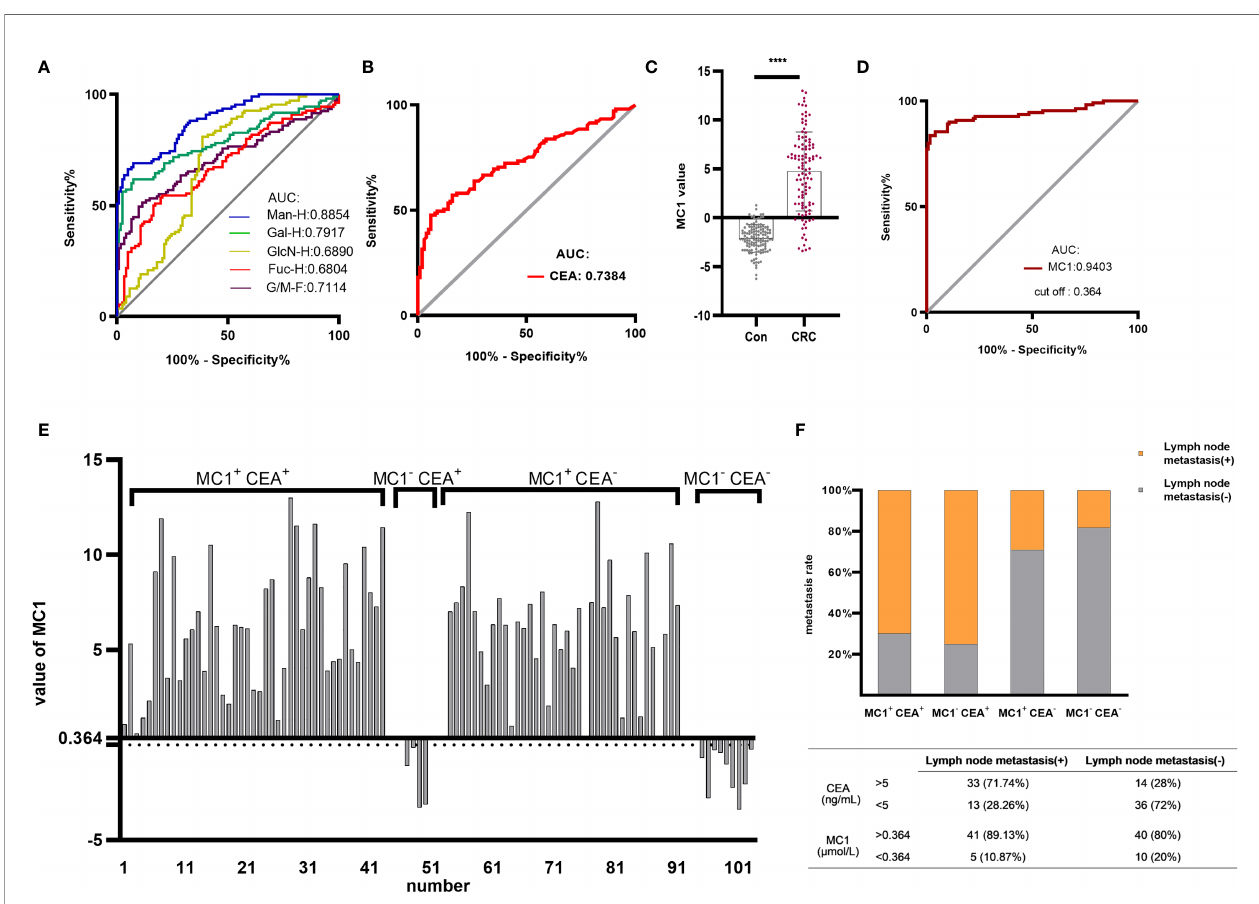
FIGURE 4 | Establishing the MC1 diagnostic model for CRC and evaluating its diagnostic performance. ROC analysis differentiated healthy individuals from CRC patients using monosaccharides (A) and CEA (B) . Based on the serum monosaccharides concentrations in healthy individuals and CRC patients, a diagnostic model named MC1 was constructed by logistic regression analysis. (C) MC1 values were compared between healthy individuals and CRC patients in the training group. (D) ROC curve analysis of MC1 was performed to differentiate healthy individuals from CRC patients. The cut-off value (0.364) of MC1 in ROC curve analysis was used as the critical value. MC1>0.364 was de fi ned as MC1 + , otherwise, it was MC1 - ; meanwhile, CEA>5ng/mL was de fi ned as CEA + , otherwise, it was de fi ned as CEA - . (E) Patients in the training group were divided into four groups: MC1 + CEA + , MC1 - CEA + , MC1 + CEA - and MC1 - CEA - , and (F) the lymph node metastasis rate in each group was counted. **** p ≤ 0.0001.